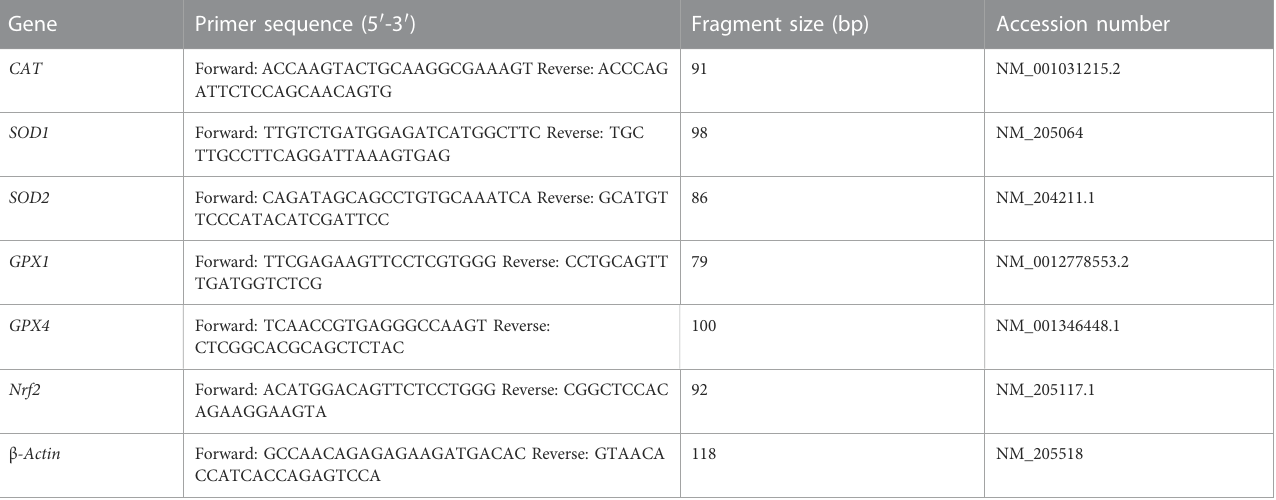
TABLE 3 Primer sequences used for quantitative real-time PCR.